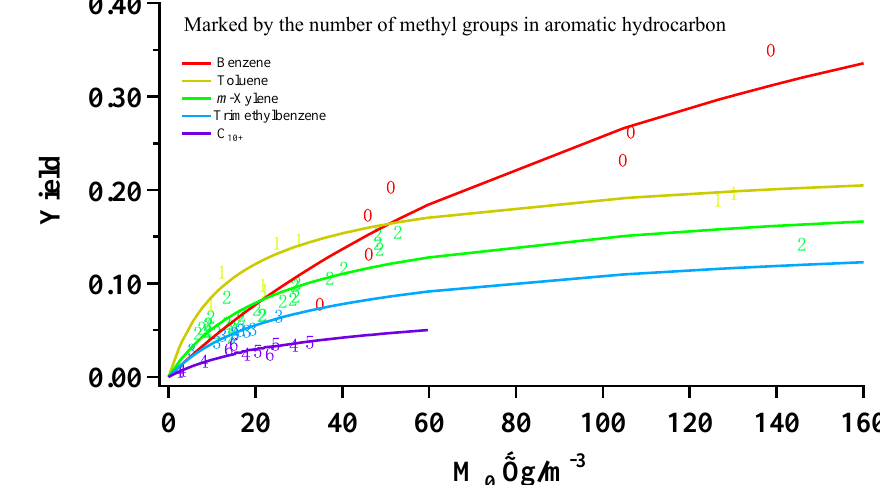
Figure 1. Aromatic SOA yields as a function of M 0 . Note: Song et al. (2005) m -xylene data are also